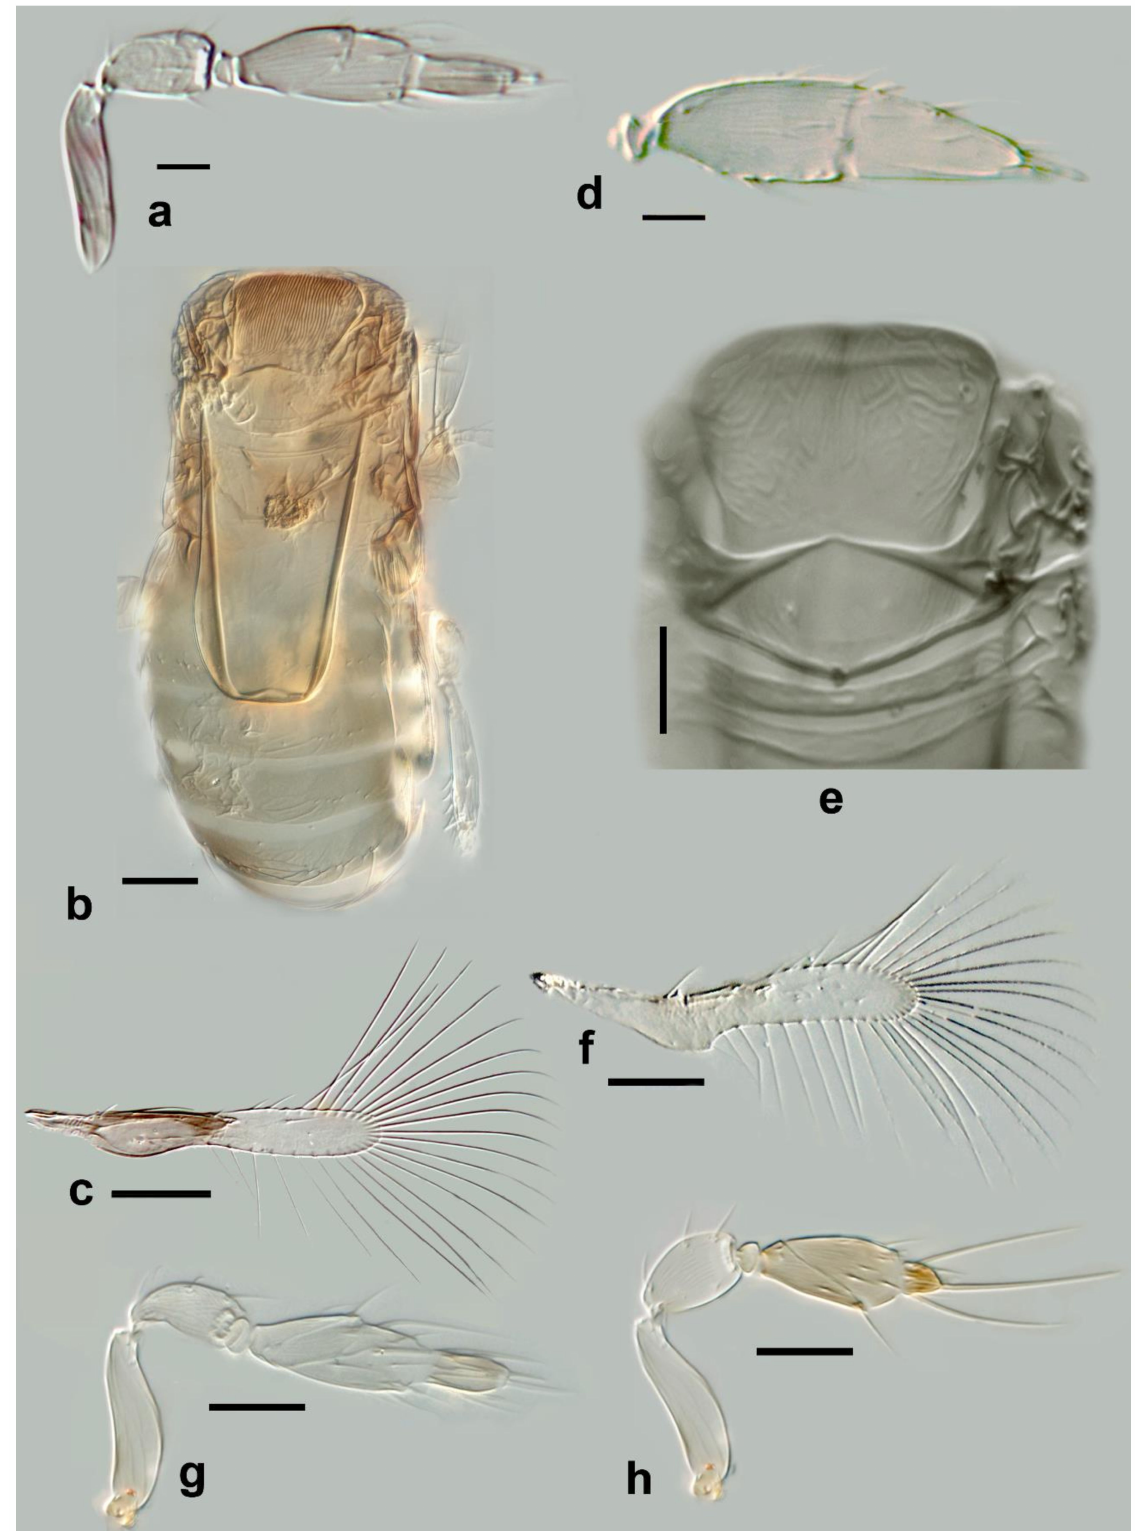
Figure 12. Photographs of Megaphragma species: ( a ) M. breviclavum , female antenna (Holotype); ( b ) M. breviclavum , female dorsal meso- and metasoma, composite image (Holotype); ( c ) M. breviclavum , female fore wing (Holotype); ( d ) M. caribea , female antenna (flagellum only) (Paratype); ( e ) M. caribea , female dorsal mesosoma (Paratype); ( f ) M. caribea , female fore wing (Paratype); ( g ) M. chienleei , female antenna (Holotype); ( h ) M. chienleei , male antenna (Paratype). Scale bars 20 µ m except 50 µ m for b, c, and